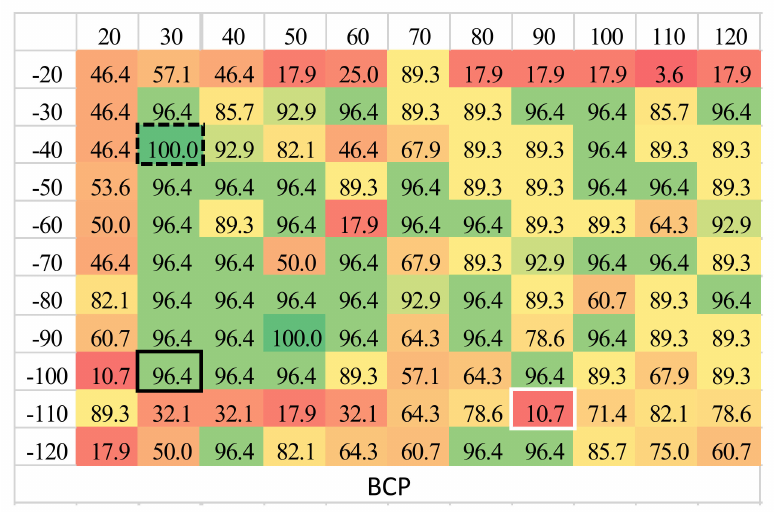
Figure 5. Heat map for the BCP algorithm for event 22 (green—max PC value, red—min PC value). Three PC values are highlighted: best (dashed black rectangle), worst (white rectangle), and the one for best overall evaluation time frame (black